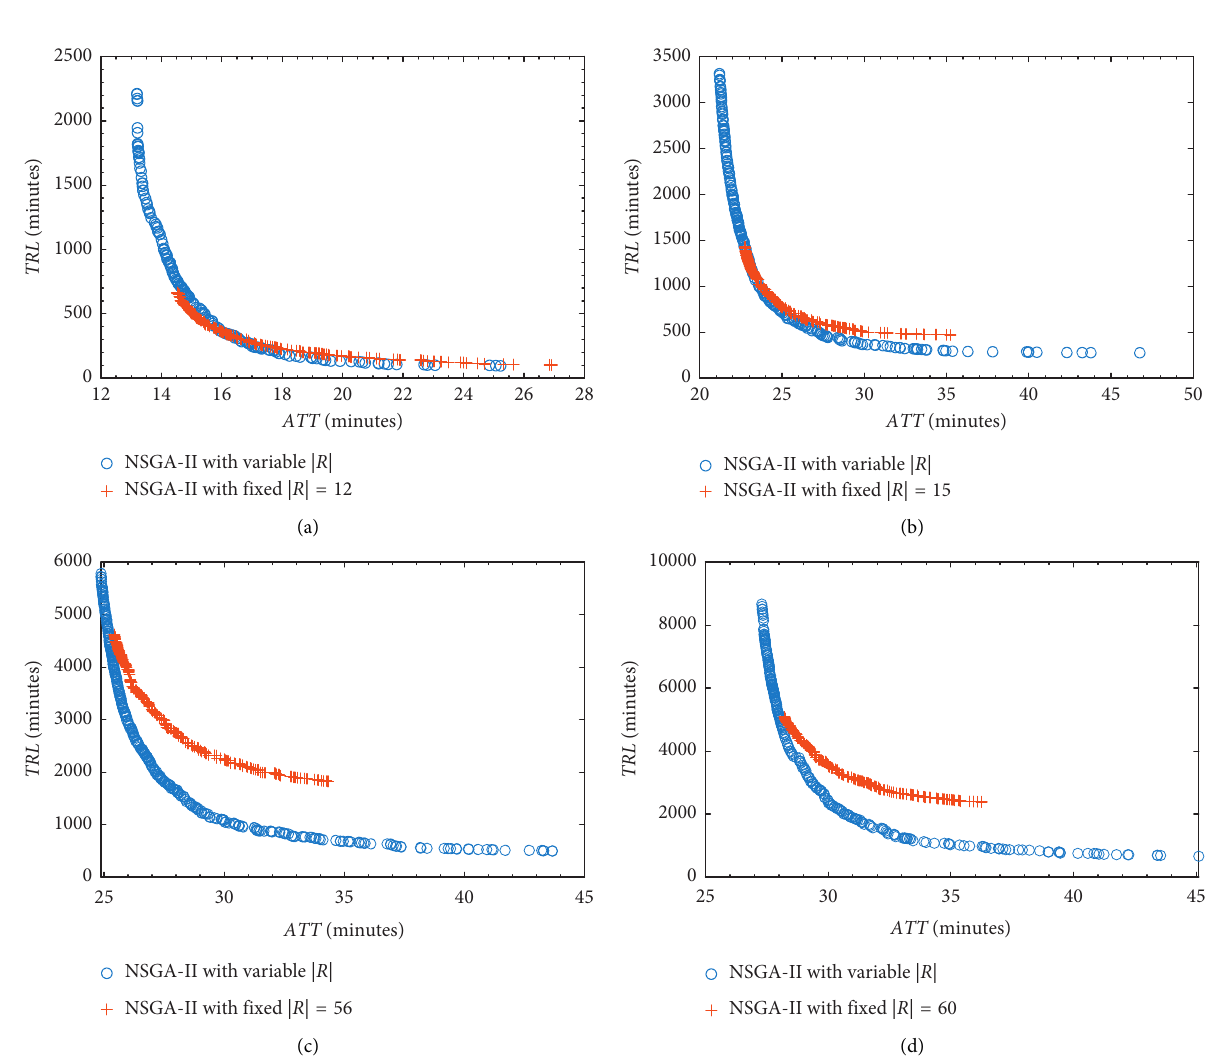
Figure 9: Approximate Pareto fronts generated by the NSGA-II with variable and fixed | R | for Mumford’s networks. (a) Mumford0. (b) Mumford1. (c) Mumford2. (d) Mumford3.